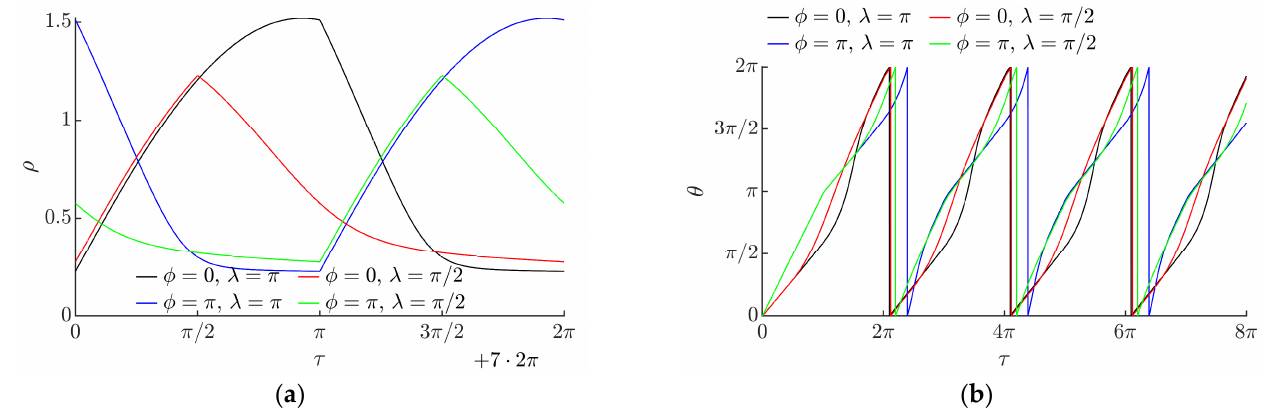
Figure 7. Angular velocity vector vs. the nondimensional time when μ 0 = 0.2, ⟨ μ m ⟩ / μ 0 = 0.25, γ = 4.9: ( a ) magnitude ρ during the period of the 8th cycle; ( b ) phase θ during the first four cycles.